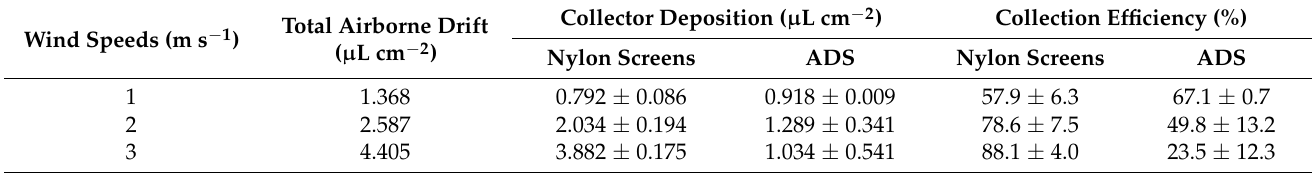
Table 2. Collection efficiencies of the two airborne drift collectors with respect to the wind